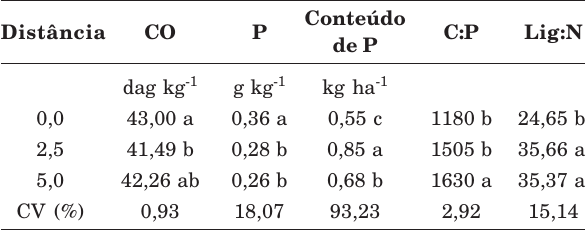
C:P e relação lignina:N da serapilheira existente em pastagens de braquiária consorciada com leguminosas